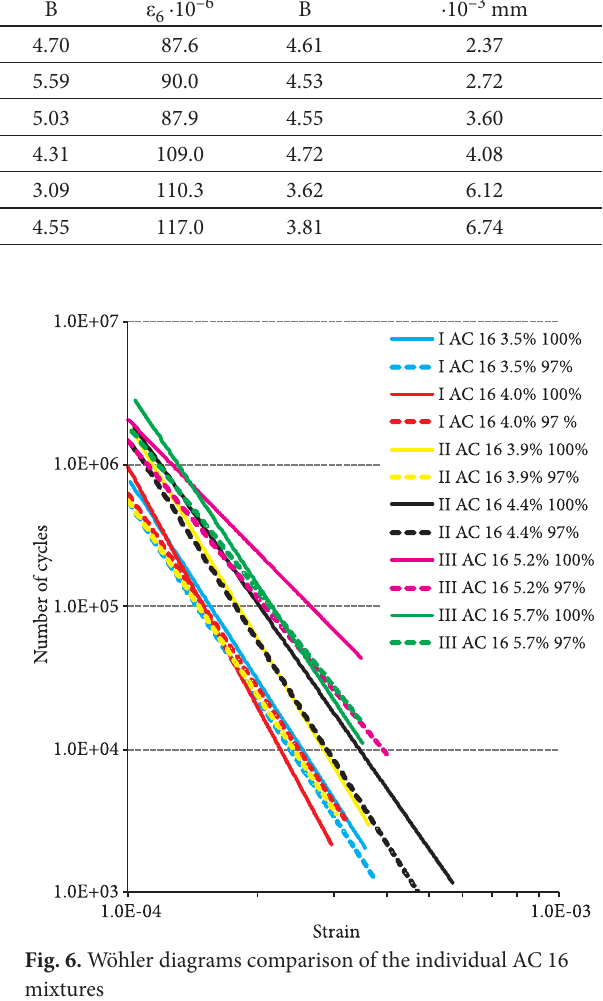
Table 5. Fatigue characteristics of AC 16 type mixtures Mixture